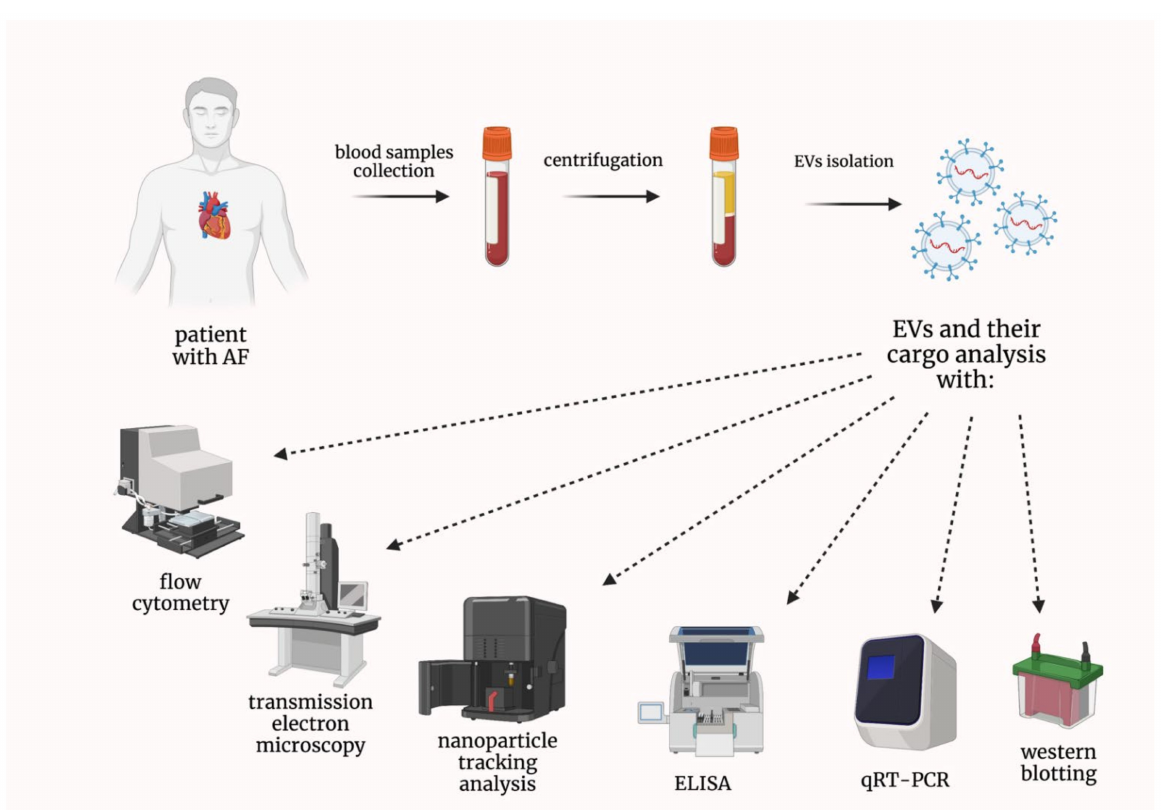
Figure 1. Techniques used in the analysis of both extracellular vesicles and their cargo. AF—atrial fibrillation; ELISA—enzyme-linked immunosorbent assay; EVs—extracellular vesicles; qRT-PCR— quantitative real-time reverse transcription polymerase chain